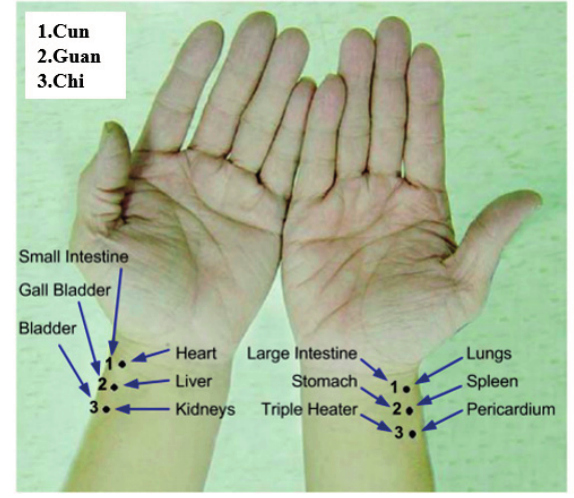
Figure 2. Correspondence between the three pulse points on both hands and the body organs.